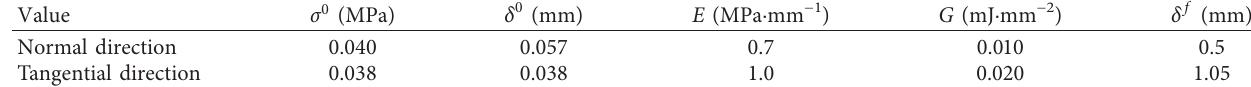
Table 2: Parameters of the cohesive zone model.